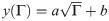
Refined data analysis for local marriages in Switzerland.Panel a: log-log scale plot of LMαi,y versus Γαi,y, where different regions are denoted in different colours and symbols, as explained in the legend. These data are properly binned (green squares) and best-fitted (solid line) by y(Γ)=aΓ+b, in agreement with the theoretical result (2). The best-fit coefficients are a = 1.20 and b = 1.93 ⋅ 10−7. Notice that the parameter b accounts for the standard deviation associated to binned data. In general, the various regions seem to be homogeneously scattered around the best-fit curve. In the insets we show, as examples, the data pertaining to two selected regions, namely Bern (upper inset) and Jura (lower inset). Notice that for both the best-fit previously obtained for the whole data set (solid line) still provides a very good fit. Panel b: For each region we calculate ρ
α, as defined in the text and deepened in the Theoretical Protocol Section. The horizontal line is drawn as a reference for the unitary value. Notice that for most regions the deviation with respect the unitary value is within the error bar. The largest deviation from the unitary value is for Glarus, which also exhibits the smallest mean value of Γ. Given that, a few cases apart, all the regions are compatible with the overall best fit no further analysis on territorial homogeneity are performed. The colormap presented in panel c highlights the deviation of ρ
α with respect to the unitary value.